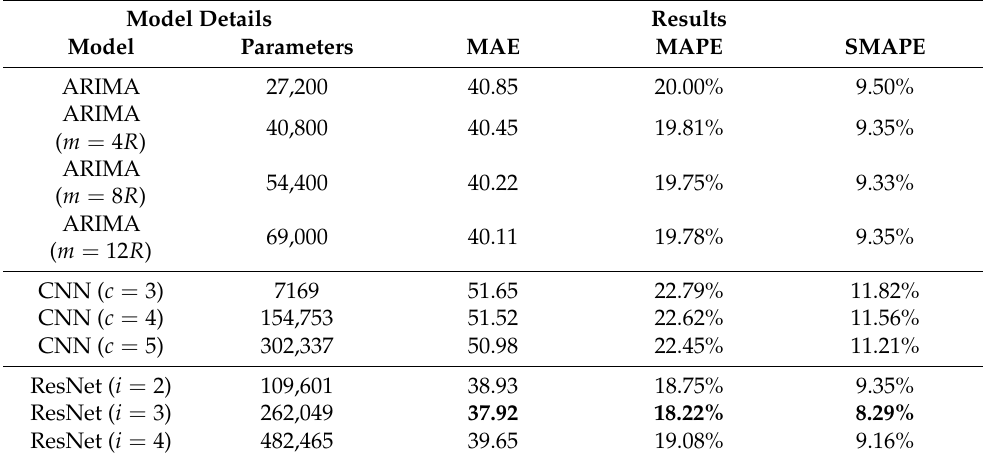
Table 1. Results obtained on the 2019 testing dataset with all of the proposed models. MAE, mean absolute error; MAPE, mean absolute percentage error; SMAPE, symmetrical mean absolute percentage error.